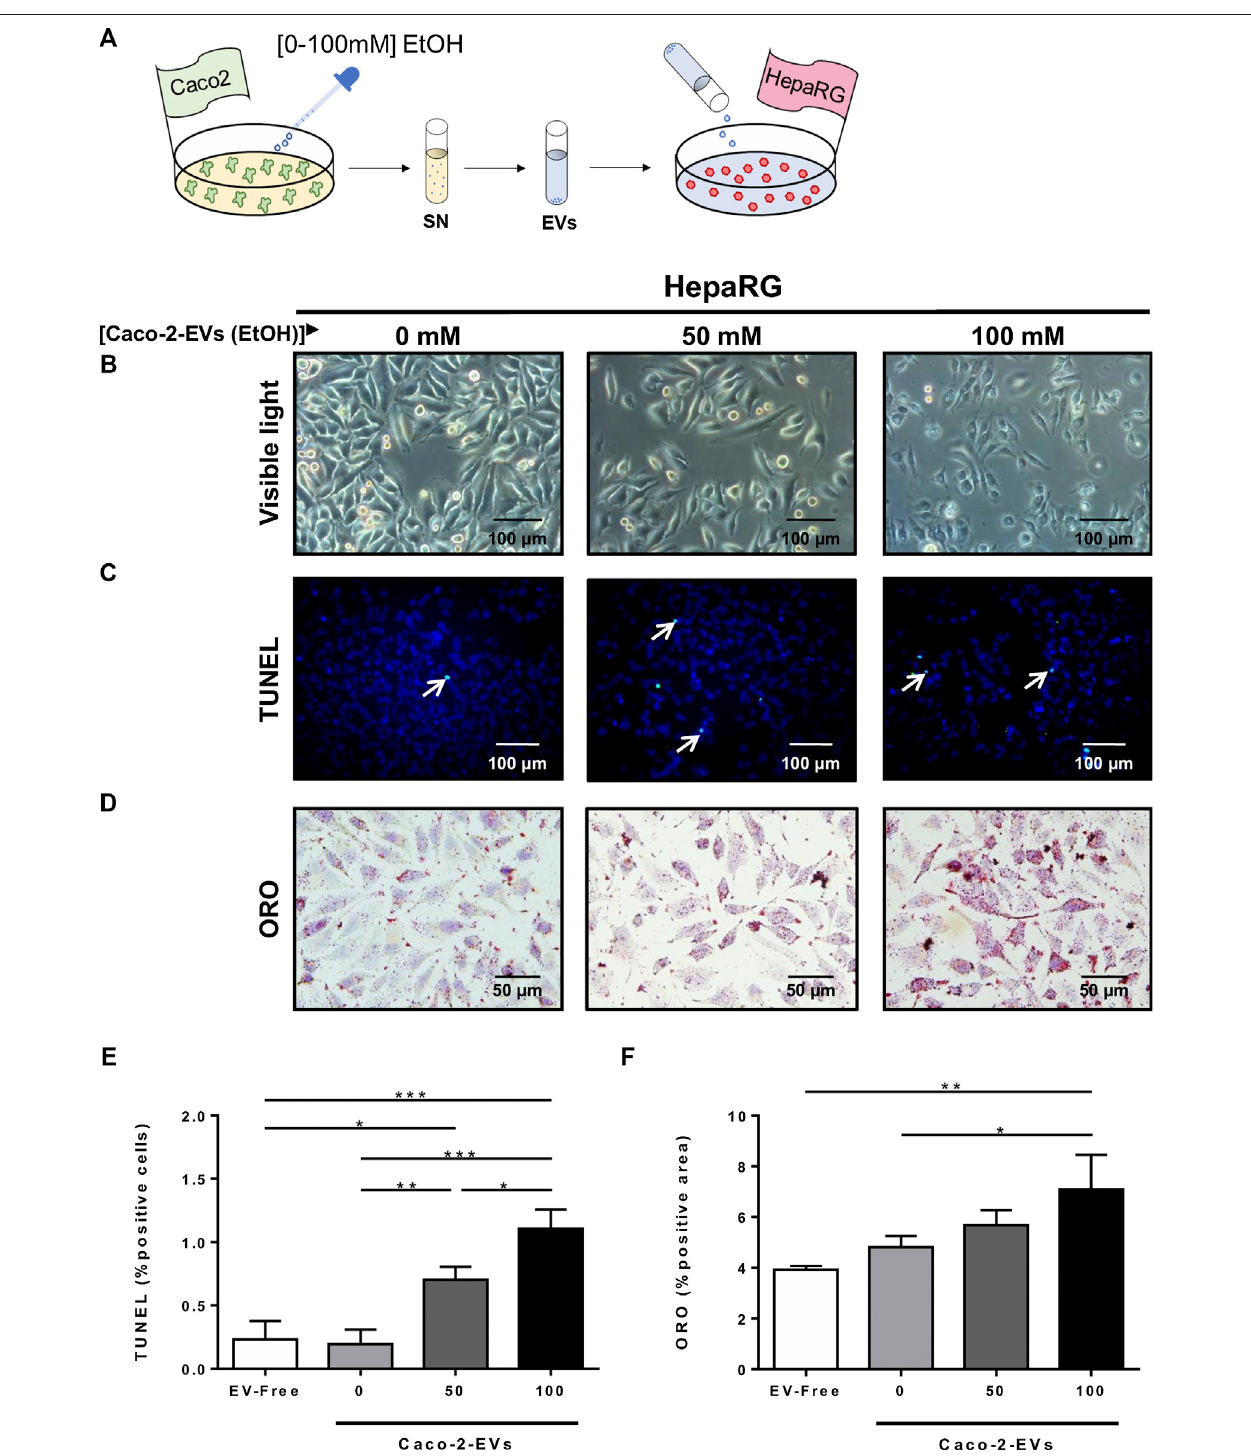
FIGURE 5 | Extracellular vesicles released from IECs trigger hepatocyte cell damage in vitro . (A) Cultures of HepaRG cells were treated with EVs isolated by ultracentrifugation from the supernatant of Caco-2 cells previously exposed to different concentrations of EtOH [0 – 100 mM]. (B) Morphology analysis of HepaRG cells by visiblelight. (C) TUNELstainingwasperformedinHepG2cellsexposedtoEVsfromEtOH-pretreatedCaco-2-cells. (D) OROstainingperformedinHepaRGcellschallenged withEVsfromEtOH-pretreated Caco-2-cells. (E) Quanti fi cationofTUNELpositiveHepaRGcellsafterchallengewithEVsisolatedfromthesupernatantofCaco-2cells previously treated with different concentrations of EtOH[0 – 100 mM] ( n (cid:1) 3/group). (F) Quanti fi cation oflipid dropletsby ORO positive area in HepaRG cells challenged with EVs isolated from the supernatant of Caco-2 cells previously treated with different concentrations of EtOH [0 – 100 mM] ( n (cid:1) 3/group; * p < 0.05, *** p < 0.001).